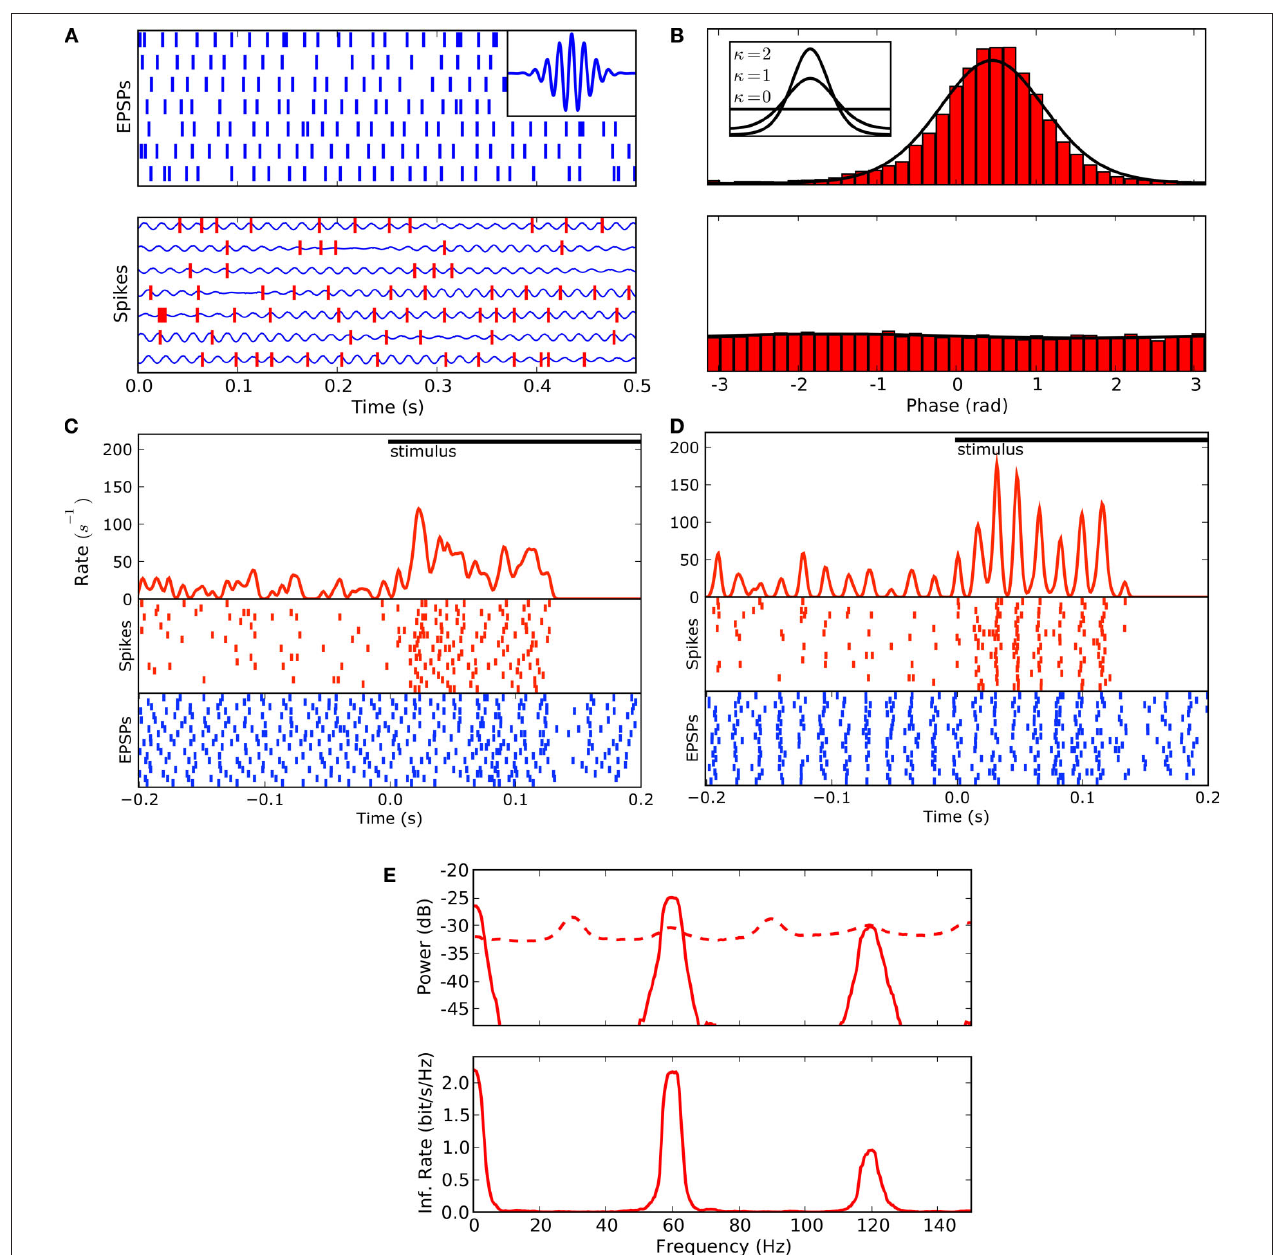
FIGURE 8 | Adjusting response latency according to the phase of ongoing oscillations reduces temporal jitter in spike timings across trials. (A) EPSP trains (top, blue) and spikes (bottom, red) for seven trials, analytical signal (bottom, blue curve) computed by fi ltering EPSP trains obtained from single trials with a Morlet wavelet (inset). (B) Histogram of spike phases (top) and shift predictor (bottom) for an oscillation frequency of 59 Hz. (C) Event times aligned to stimulus onset displayed as averaged spike rate (red curve) and rasters for